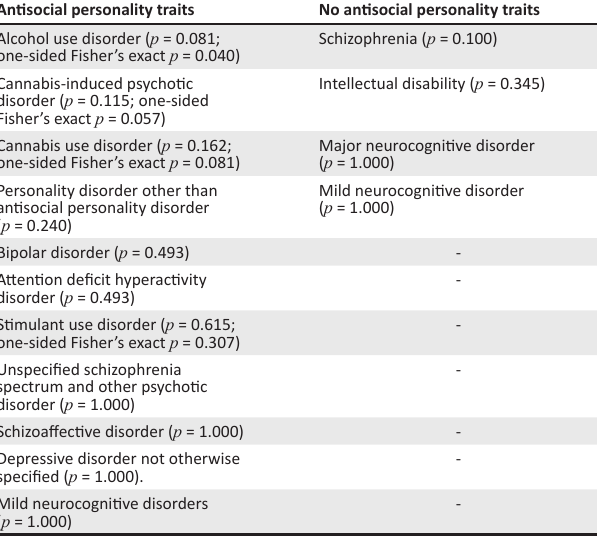
TABLE 3: Prevalence of different diagnoses in State patients with and without antisocial personality disorders. Antisocial personality traits No antisocial personality